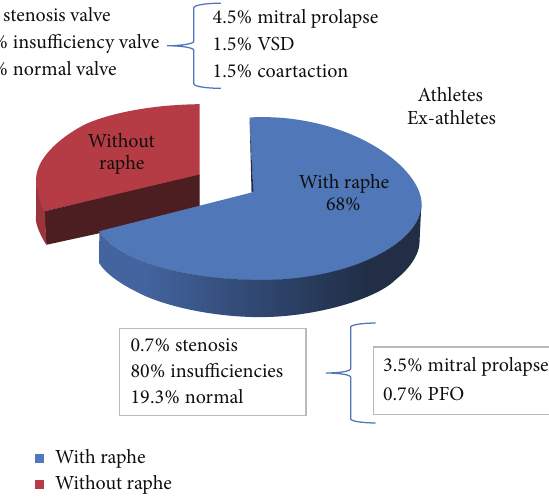
Figure 2: Presence of BAV morphologies and associated cardiac patterns in the whole athletes BAV group.